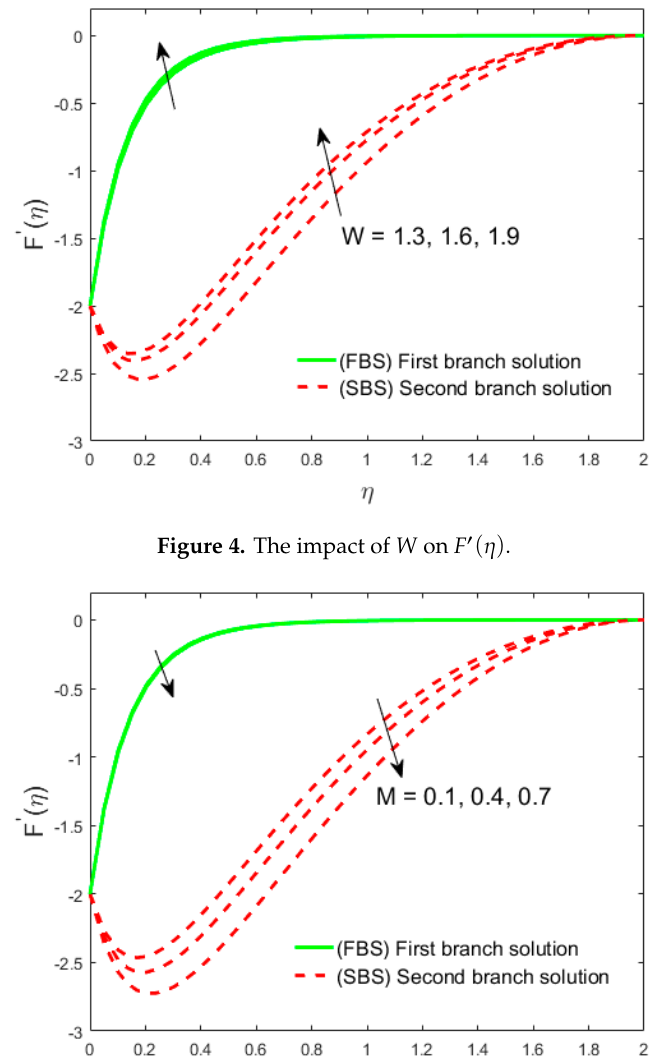
Figure 5. The impact of M on